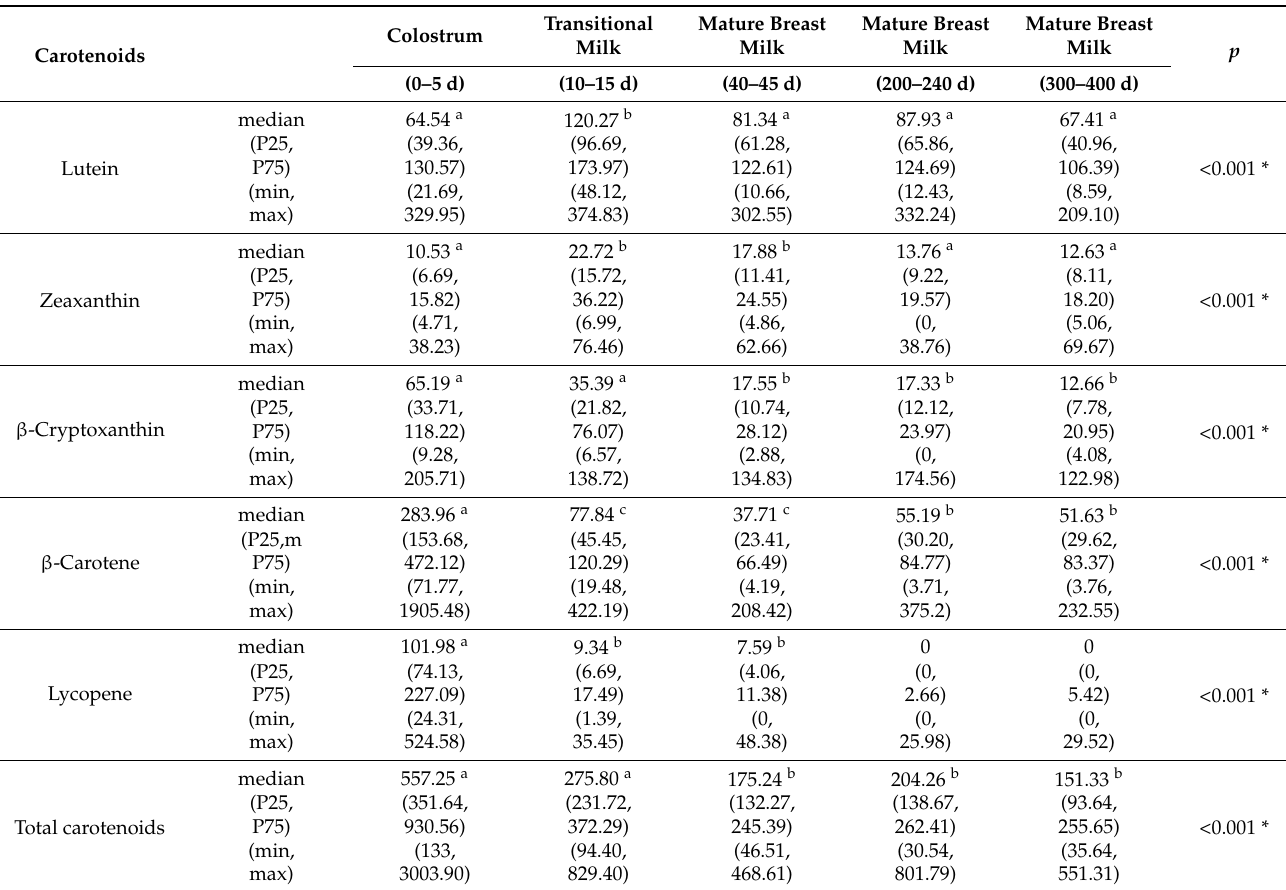
Table 5. Comparison of the contents of carotenoids in breast milk at five lactation stages in Guangzhou ( µ g/L, median (P25, P75), (min, max)).